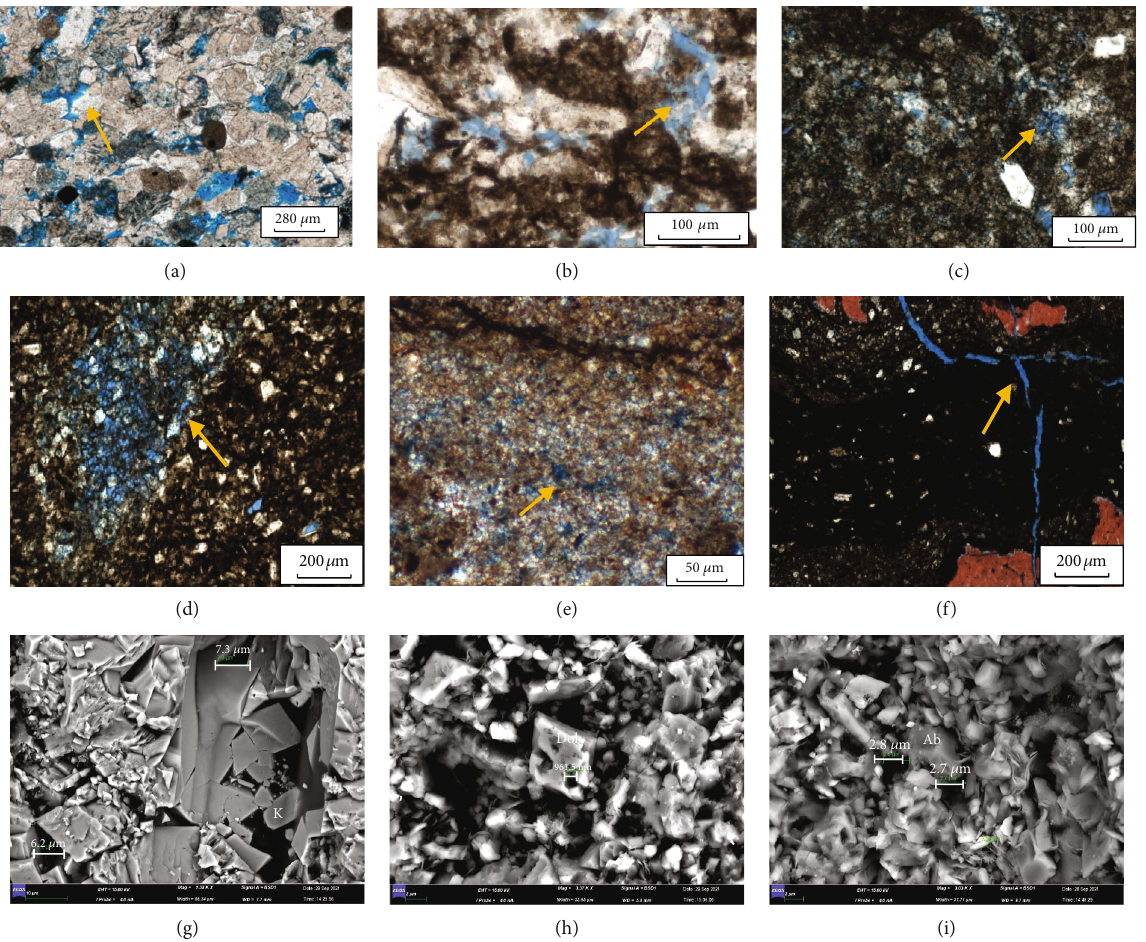
Figure 5: Di ff erent pore structure characteristics of Lucaogou Formation in Jimsar Sag: (a) fi ne-grained sandstone, with primary pores (J10025, 3555.08 m, P 2 l 2 ); (b) argillaceous siltstone, feldspar particles, and interstitials are dissolved, and intergranular dissolved and intragranular dissolved pores are developed (J10025, 3548.65m, P 2 l 2 ); (c) micrite silt containing silt dolomite, intercrystalline dissolved pores, and feldspar particles are dissolved into intragranular dissolved pores (J100024, 3484 m, P 2 l 2 ); (d) dolomitic siltstone and feldspar forms honeycomb dissolved pores (J10025, 3697.7m, P 2 l 1 ); (e) muddy silt-containing dolomite, intergranular dissolved pores, and intragranular dissolved pores (J10024, 3641.12m, P 2 l 1 ); (f) siltstone sand-calcareous shale, two intersecting microfractures